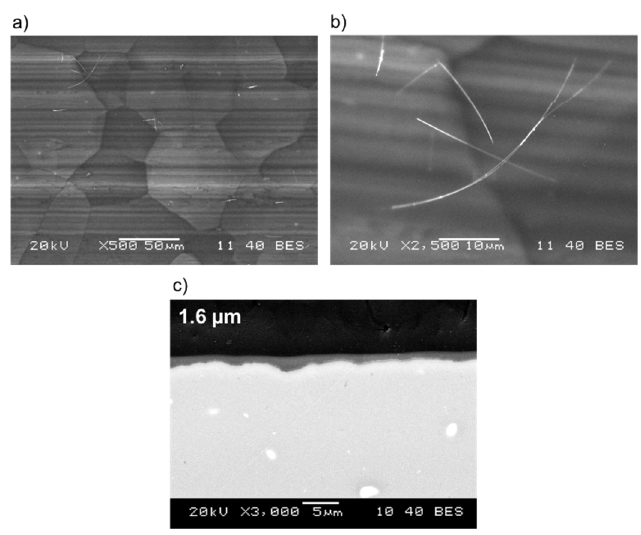
Figure 3. ( a ), ( b ) Top-view and ( c ) cross-section SEM images of coating deposited at 5 cm/min from Figure 3. ( a , b ) Top-view and ( c ) cross-section SEM images of coating deposited at 5 cm / min from Sol A Coatings 2020 , 10 , x FOR PEER REVIEW Sol A loaded with 0.5% wt Ag NW, on AA6063 T6. loaded with 0.5% wt Ag NW, on AA6063 T6.